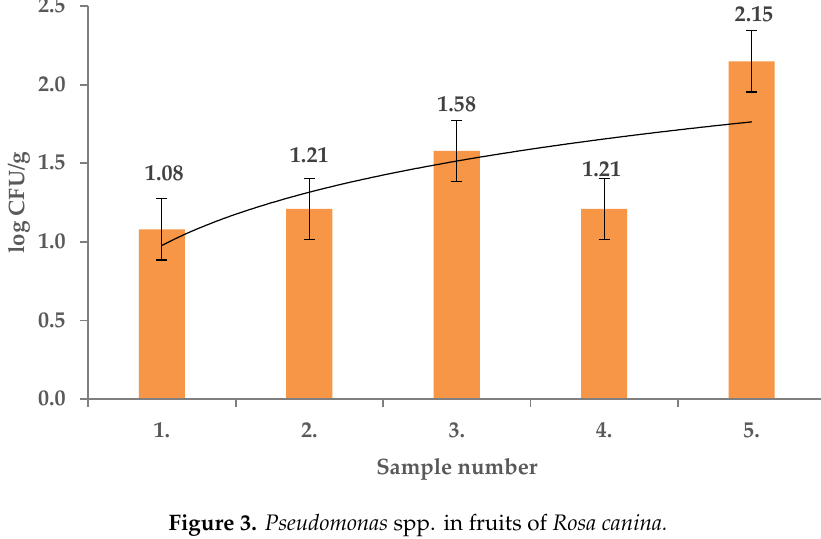
Figure 3. Pseudomonas spp. in fruits of Rosa canina.